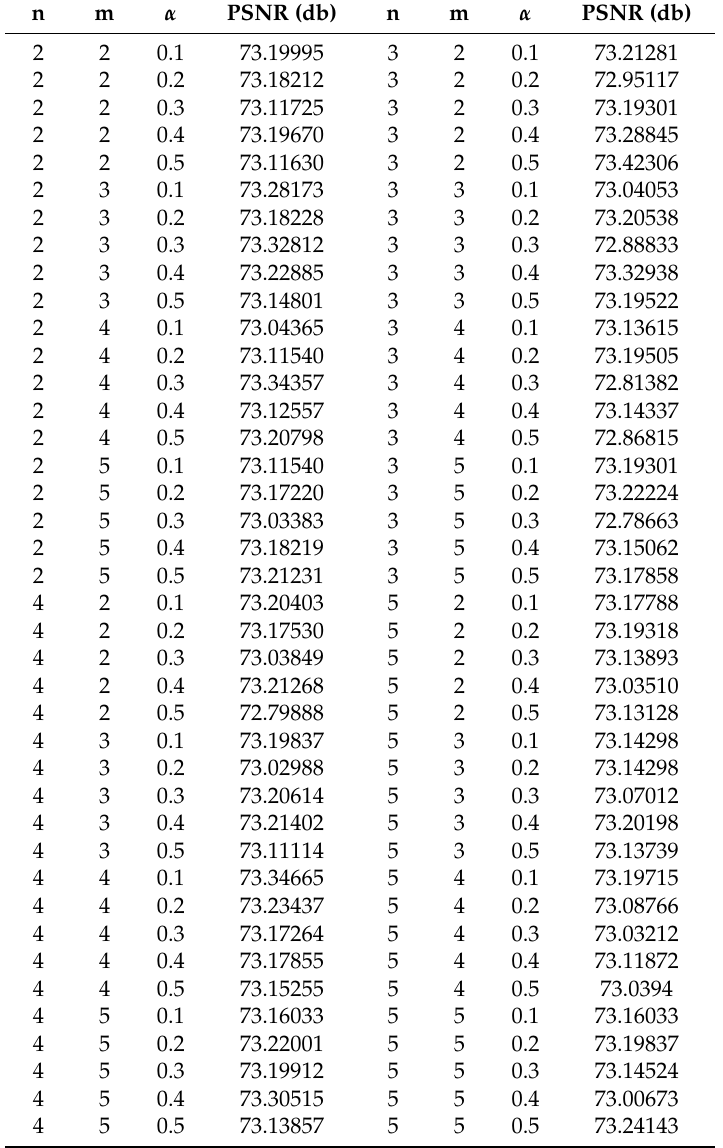
Table 1. The average objective results at different parameter values in the hypergraph